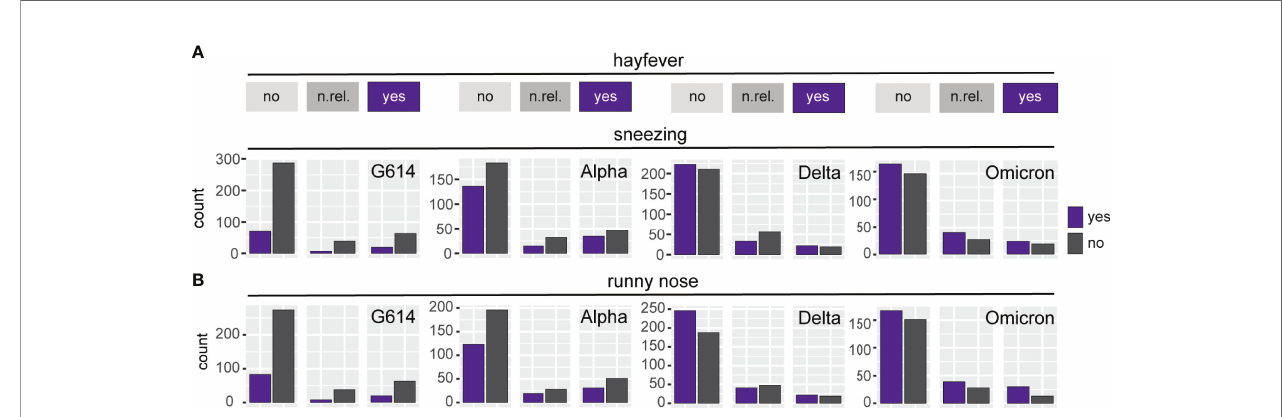
FIGURE 4 | Sneezing and runny nose symptoms strati fi ed by hayfever. Counts of respondents indicating presence or absence of the symptom “ sneezing ” (A) or “ runny nose ” (B) . Respondents were grouped according to their suffering from hayfever ( “ yes ” ), not suffering from hayvever ( “ no ” ), or suffering from hayfever but not during the time of SARS-CoV-2 infection ( “ n.rel. ” : not relevant). The increase in frequency of the symptoms “ sneezing ” and “ runny nose ” in the variant dominated phases can be clearly observed in individuals who do not suffer from